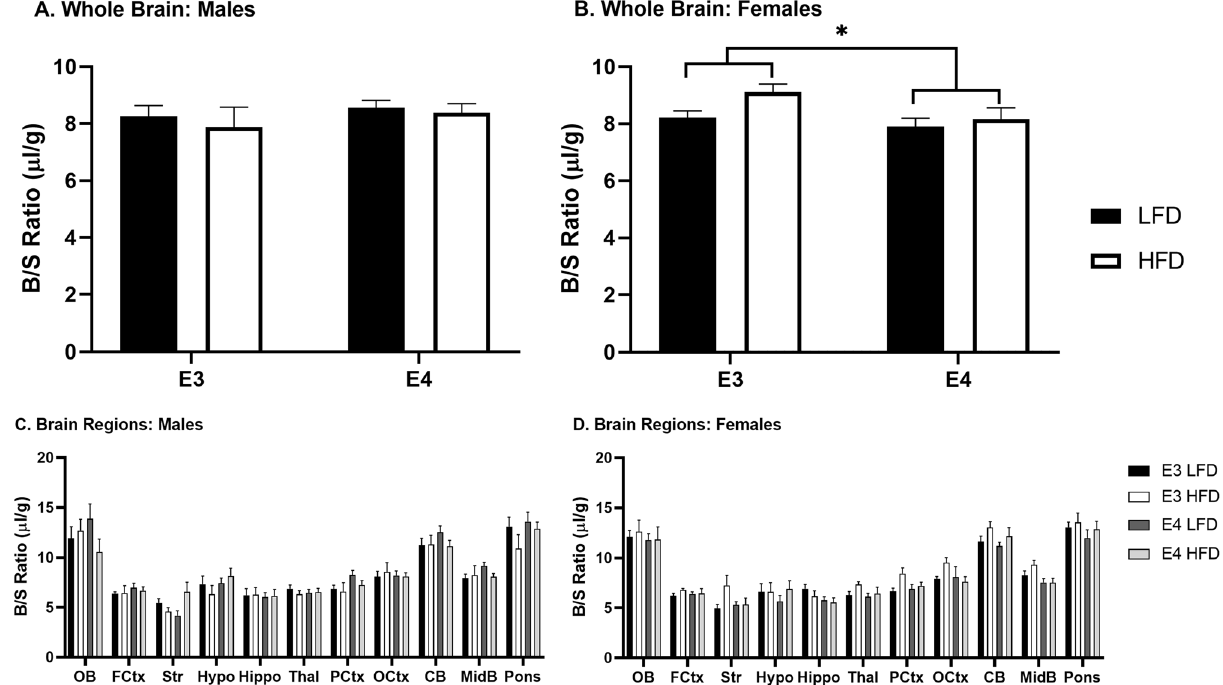
Figure 3. Vascular space. Whole brain vascular space for ( A ) males and ( B ) females were analyzed by a two- way ANOVA and females had significant differences due to genotype (* p < 0.05). Brain region vascular space for ( C ) males and ( D ) females were analyzed by repeated measures. Males had a significant interaction between vascular space, diet, and genotype ( p < 0.05). There were no brain region differences for females. There were not post-hoc differences. n = Males: E3 LFD = 14, E3 HFD = 7, E4 LFD = 9, E4 HFD = 7; Females: E3 LFD = 9, E3 HFD = 10, E4 LFD = 10, E4 HFD =